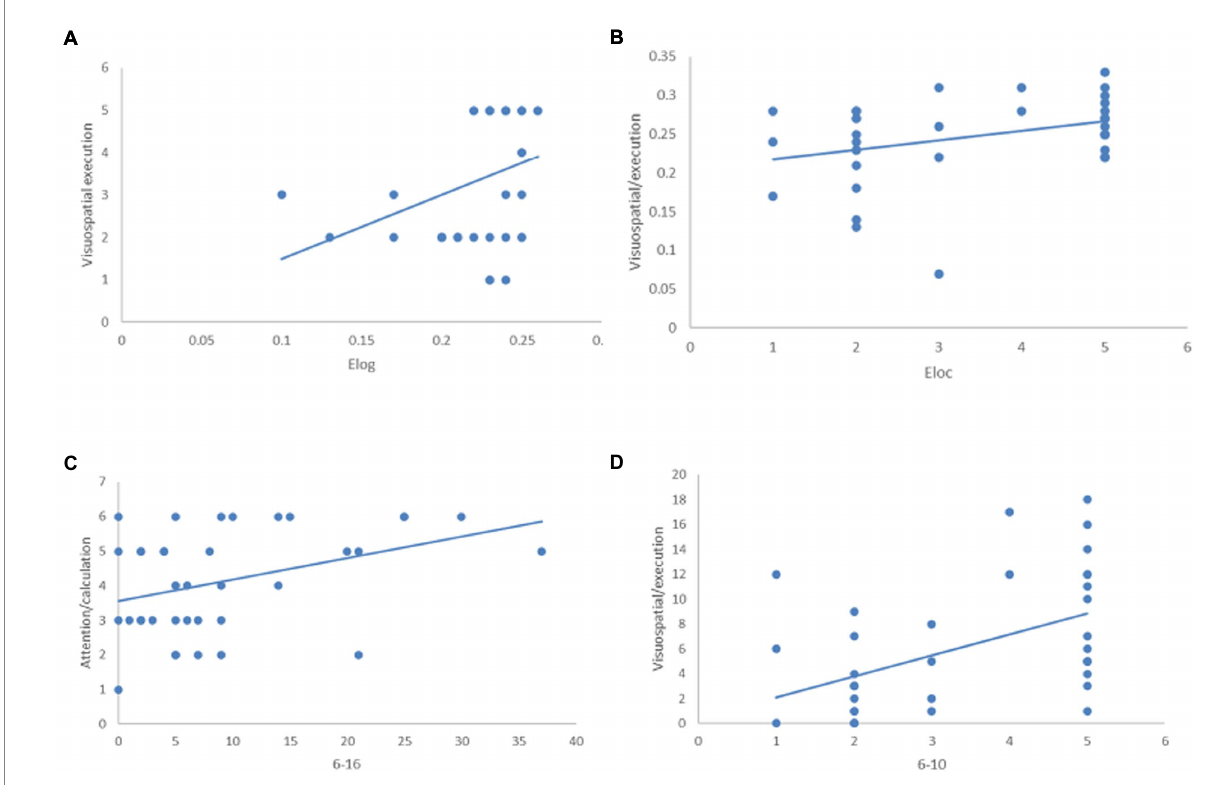
FIGURE 4 The relationship between global properties of brain network, edge analysis and MoCA scale. In CHF + CI group, Elog, Eloc and 6–10 are positively correlated with Visuospatial/Executive function (A) p = 0.042; (B) p = 0.031; (C) p = 0.002; 6–16 is positively correlated with attention/calculation (D) , p =